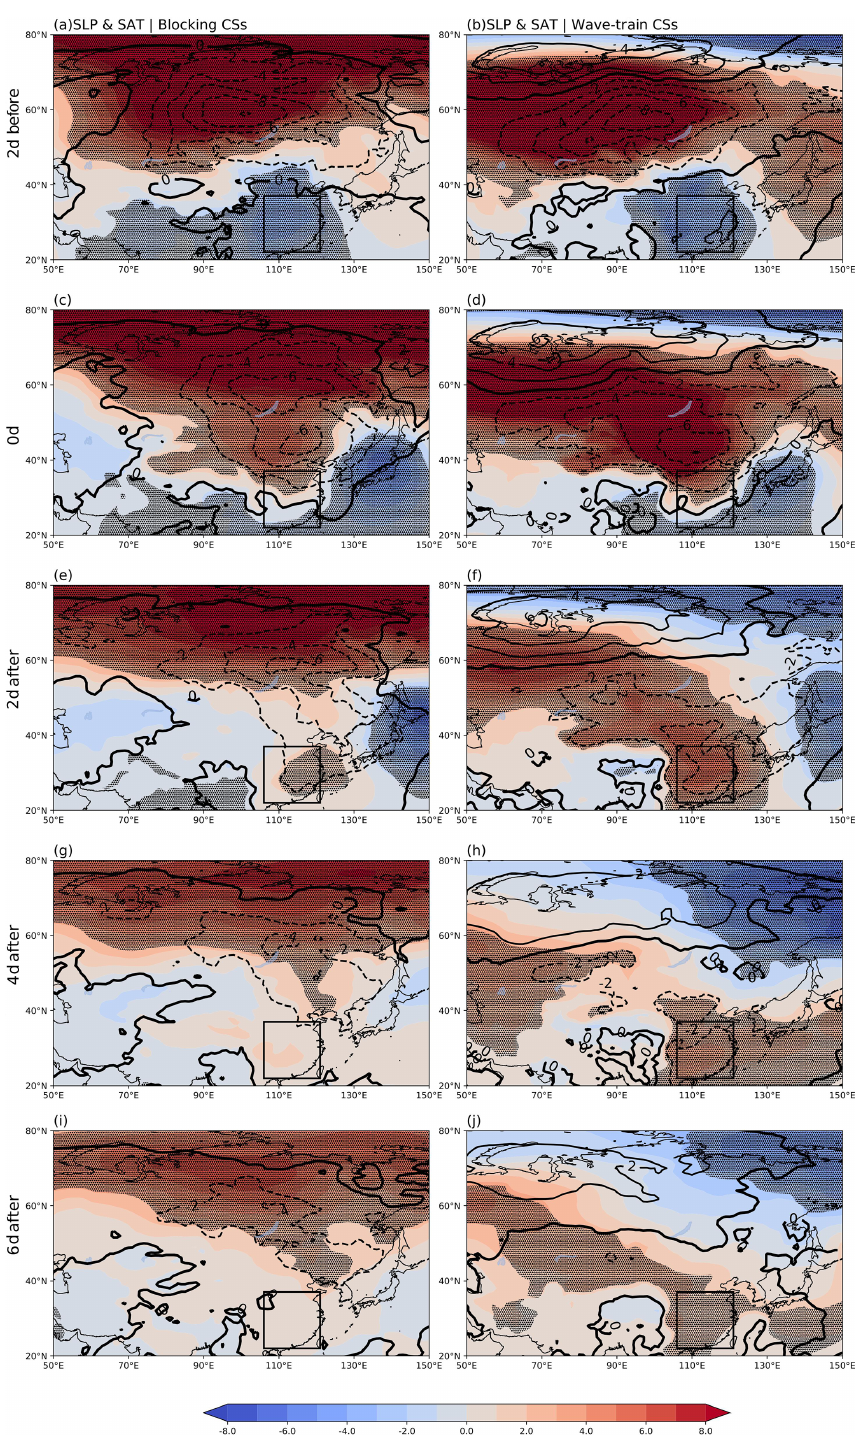
Figure 8. Composite anomalies of SLP (shading; hPa; dotted areas are statistically significant at the 95% confidence level) and SAT (contour; K) from − 2 to 6d relative to the outbreaks of blocking CSs (a, c, e, g, i) and the wave-train CSs (b, d, f, h, j) . The thick black isoline represents the 0 value of SAT